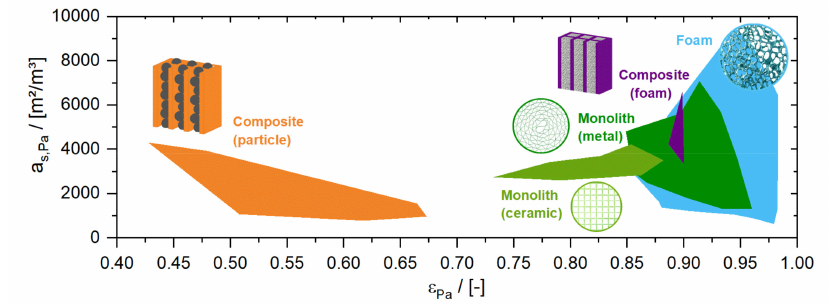
Figure 3. Comparison of bed porosity ( ε Pa ) and solid surface area ( a s , Pa ) for different structured